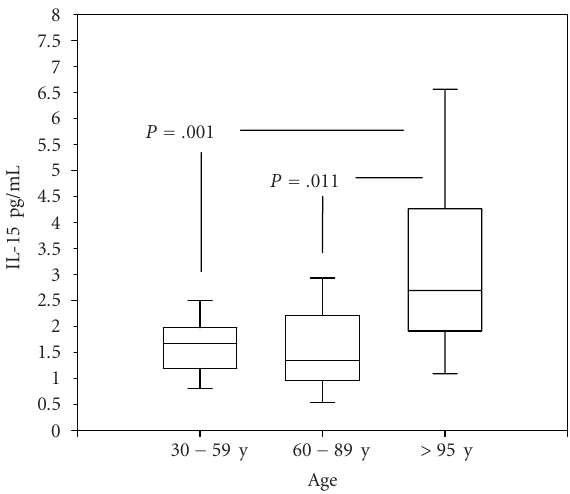
Figure 1. Age-related changes in serum IL-15 levels. Box blot il- lustrates median of IL-15 in groups of individuals with di ff erent